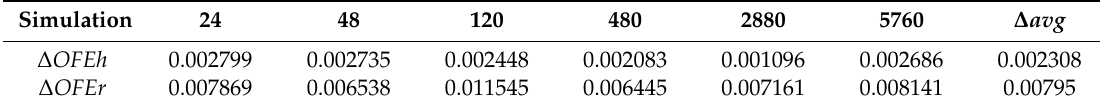
Table 4. The comparison of di ff erence ∆ between OFE for di ff erent scenarios.